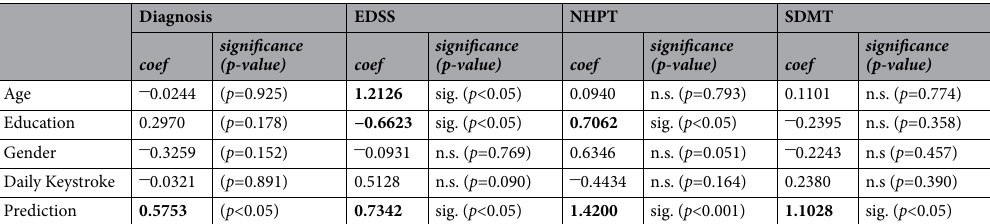
Table 2. Results of the Logistic Regression test. The demographic variables (age, gender and education), the average of the daily keystroke and the prediction probability of the best performing model are treated as independent variables, while binarized clinical outcomes are considered dependent variables. Results show that the prediction probabilities of all models exhibit a statistically significant association with the subjects’ status. Significant value are in value [bold].